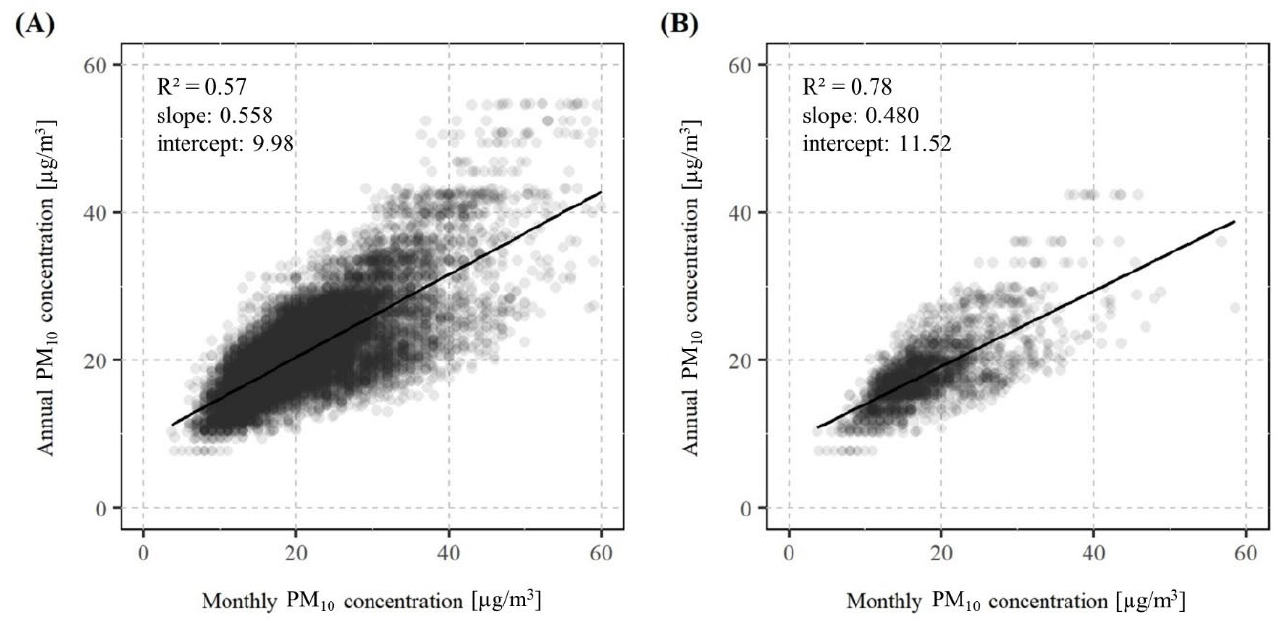
Figure 3. Evolution of the PM 10 annual concentration as a function of the monthly concentration considering ( A ) the whole dataset and ( B ) only the year 2019, and their corresponding linear regres ‐ sions.